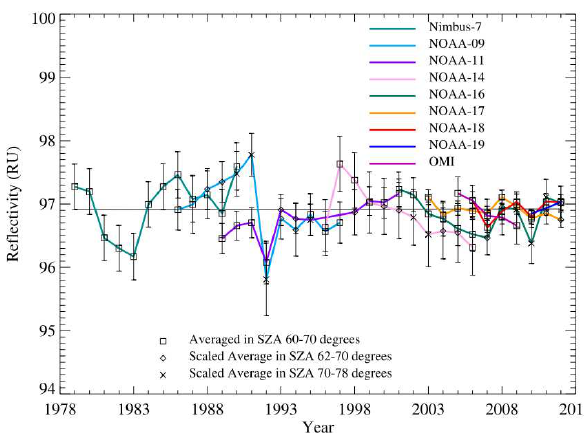
Fig. 1. Normalized summer Antarctic snow/ice LER at 340 1 1.1nm averaged between SZA 60 ◦ and 70 ◦ degrees. Squares: LER averaged over 60 ◦ < SZA < 70 ◦ . Diamonds: LER averaged over 62 ◦ < SZA < 70 ◦ . X: LER averaged over 70 ◦ < SZA < 78 ◦ and interpolated from the first year of data back to the range LER averaged over 60 ◦ < SZA < 70 ◦ . The average LER for each satellite is adjusted to 96.92RU based on the best-calibrated four SBUV/2 instruments. The error bars are derived from the standard deviation of the points describing the envelope of the LER data combined with the annual standard deviation from the